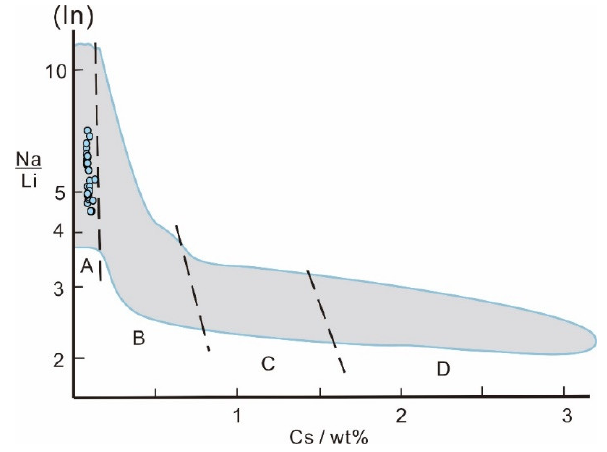
Figure 12. The Na/Li versus Cs diagram for late primary beryl from granitic pegmatites [53]. Different regions in the figure represent different types of pegmatites. A = barren and geochemically primitive beryl-type pegmatites (including most pegmatites of the rare-earth type); B = geochemically evolved beryl–columbite and beryl–columbite–phosphate pegmatites; C = albite–spodumene and complex pegmatites; D = highly fractionated Li-, Cs- and Ta-rich complex pegmatites [53,54]. Li and Cs contents are positively related. The Li versus Cs content shows two con- centrated areas: the “low-alkali beryl” and “high-alkali beryl” areas. As observed in Figure 13, aquamarine in most areas belongs to the “low-alkali beryl” area, including Longzi aquamarine.